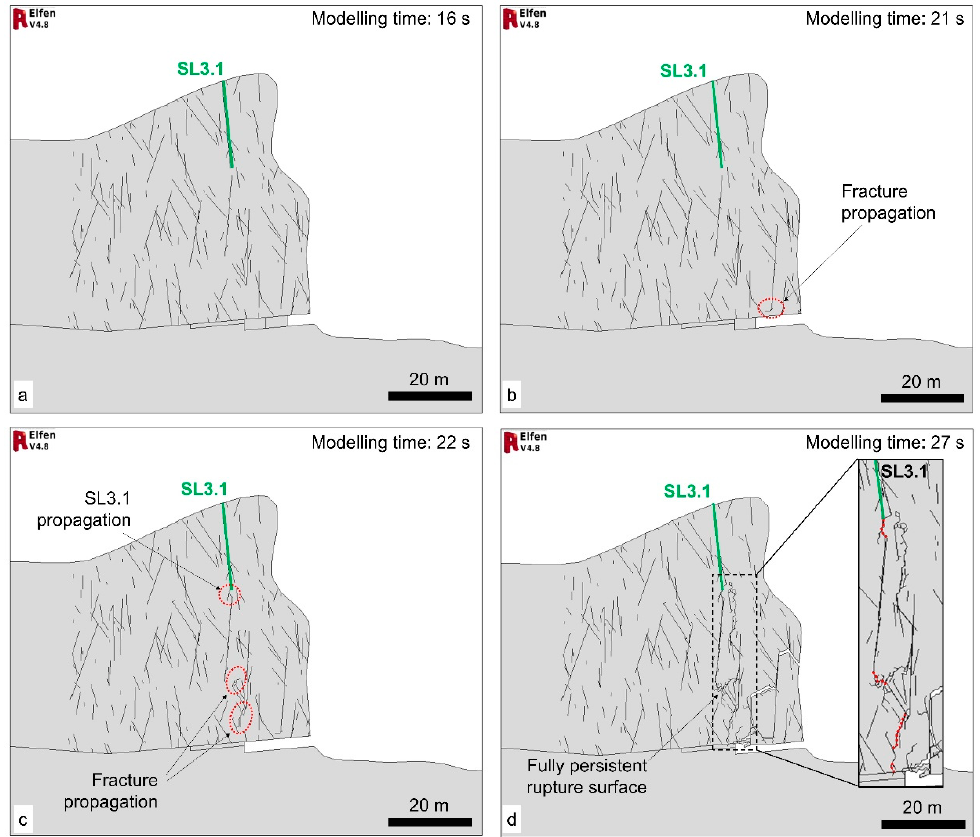
Figure 10. Overview of the San Leo landslide Model 1. ( a ) First undermining stage. No brittle damage forms; ( b ) Second undermining stage. Minor brittle fracturing is simulated at the base of the undermined slab; ( c ) Third undermining stage. Note the brittle propagation of SL3.1 and fractures at the base of the plateau; ( d ) Model after 28 s showing the formation of a continuous rupture surface (dotted, red line in the inset box).